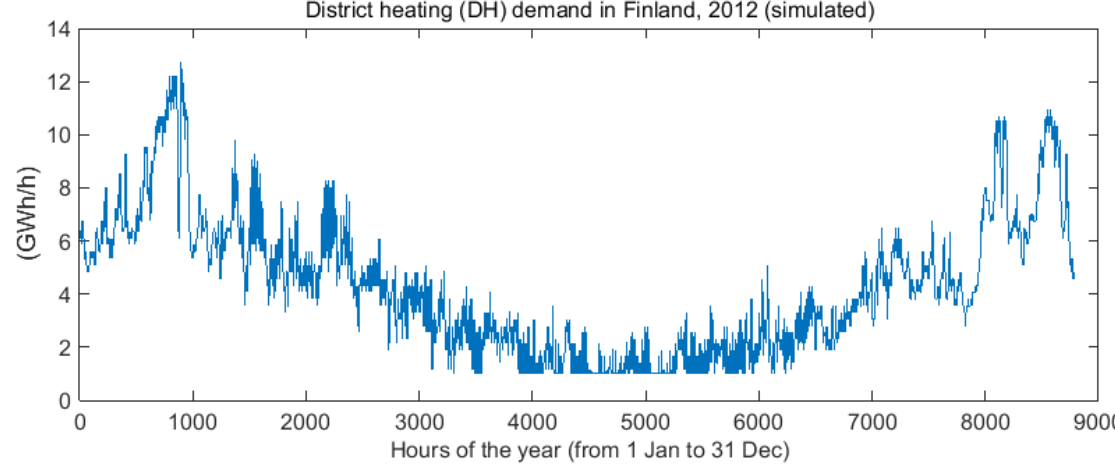
Figure B1. Modeling aggregated hourly DH demand for the whole country in 2012.